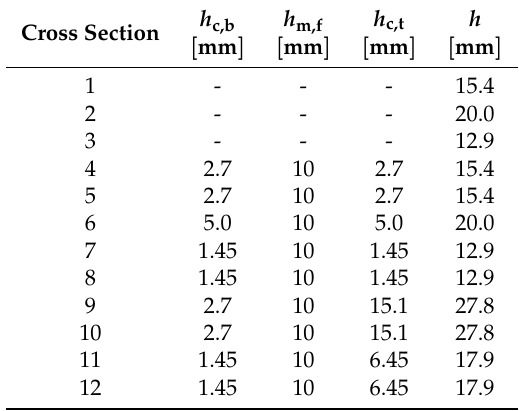
Figure 20. Cross-section with an effective strain-hardening layers either σ 3300 c or σ 3300 + 800 c representing the tested cross section and strain-softening layers σ m for add-on plain concrete layers. Table 2. Cross section layups corresponding to the curve (ii) in Figure